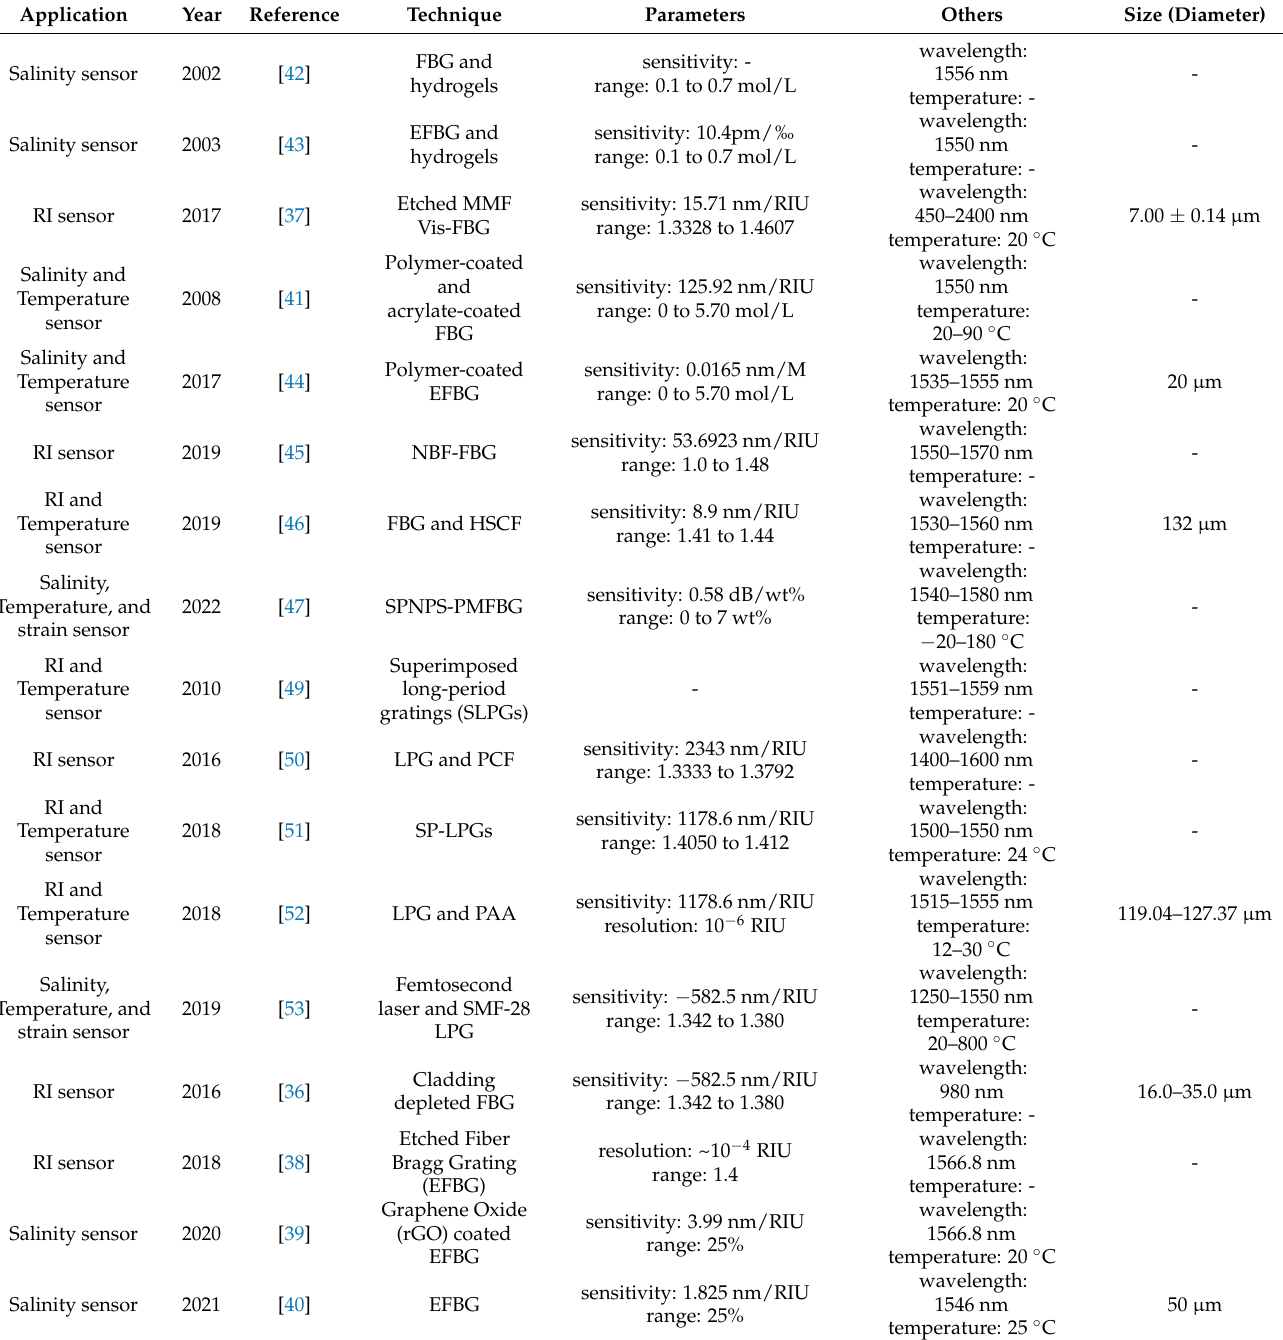
Table 2. Summary of optical